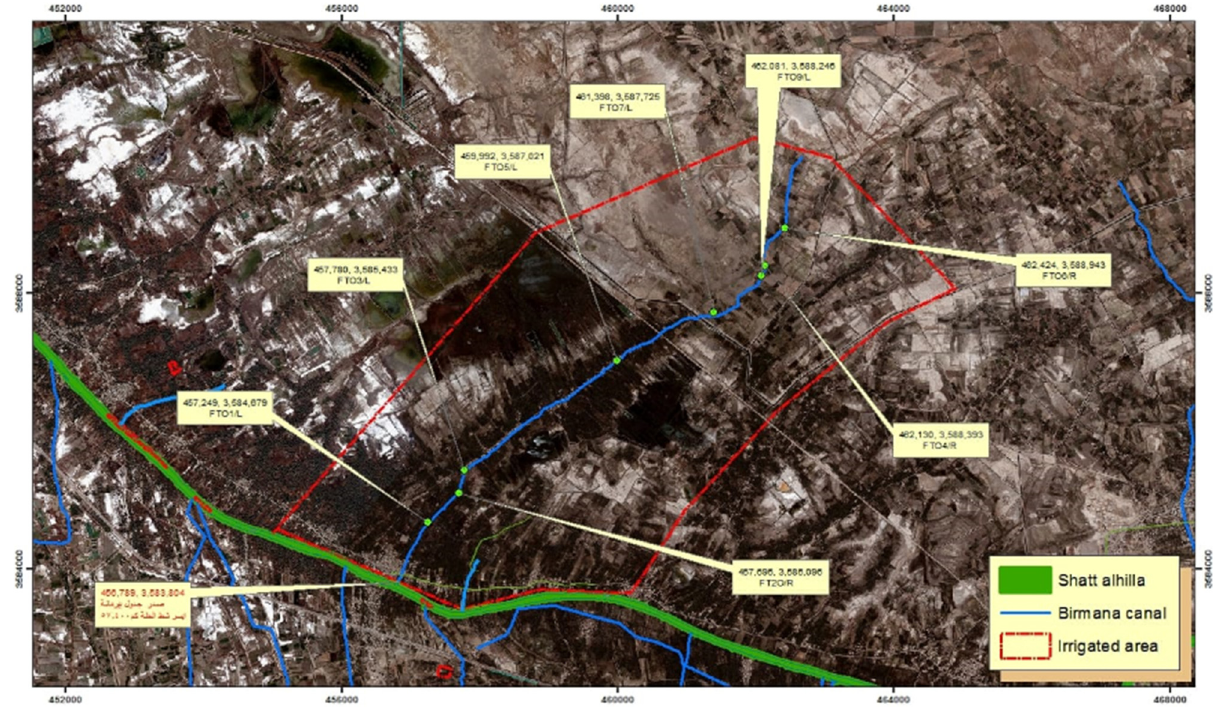
Figure 1: Birmana unlined canal ( GIS )